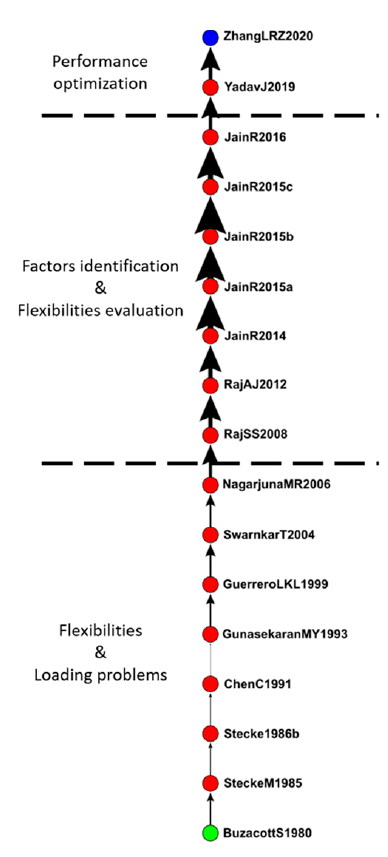
Figure 3. Global main path of FMS research.